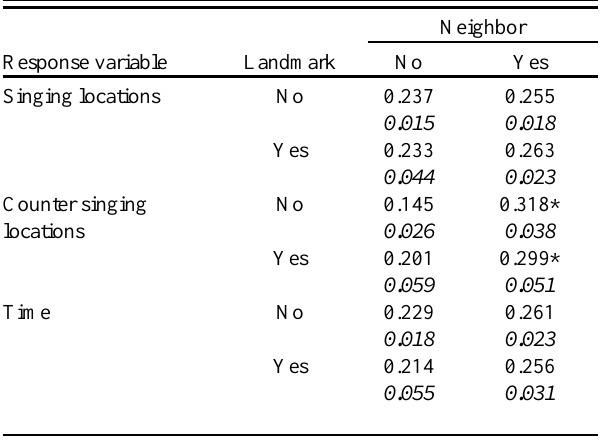
Table 4 . Mean proportion of singing locations, countersinging locations, and time spent, for all quadrants with and without landmarks and with and without neighbors. Italicized numbers represent standard errors on the mean. Asterisks indicate a significant difference in the means ( a =